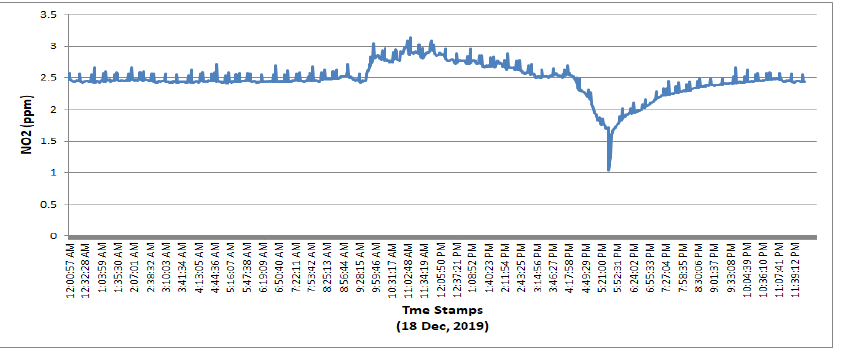
Figure 9. Variation in Concentration of NO 2 over a period of 24